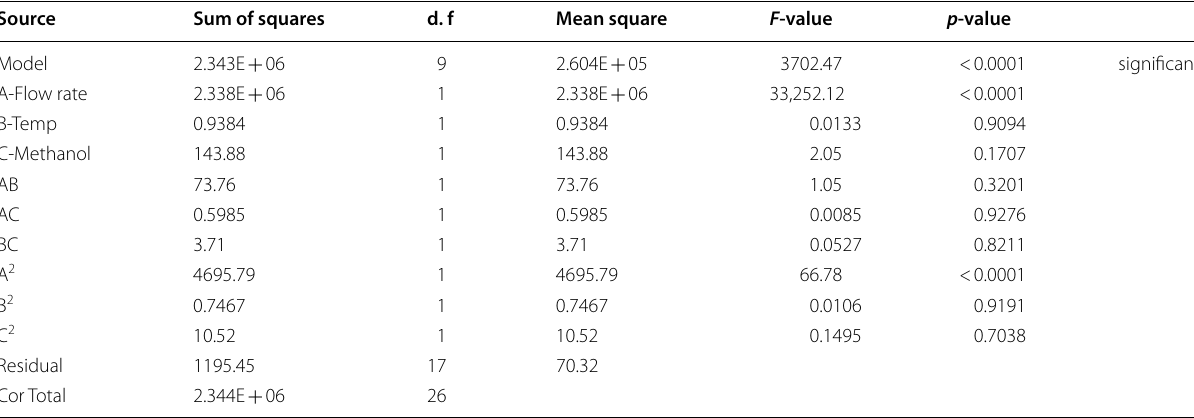
Table 6 ANOVA results for Response 2: